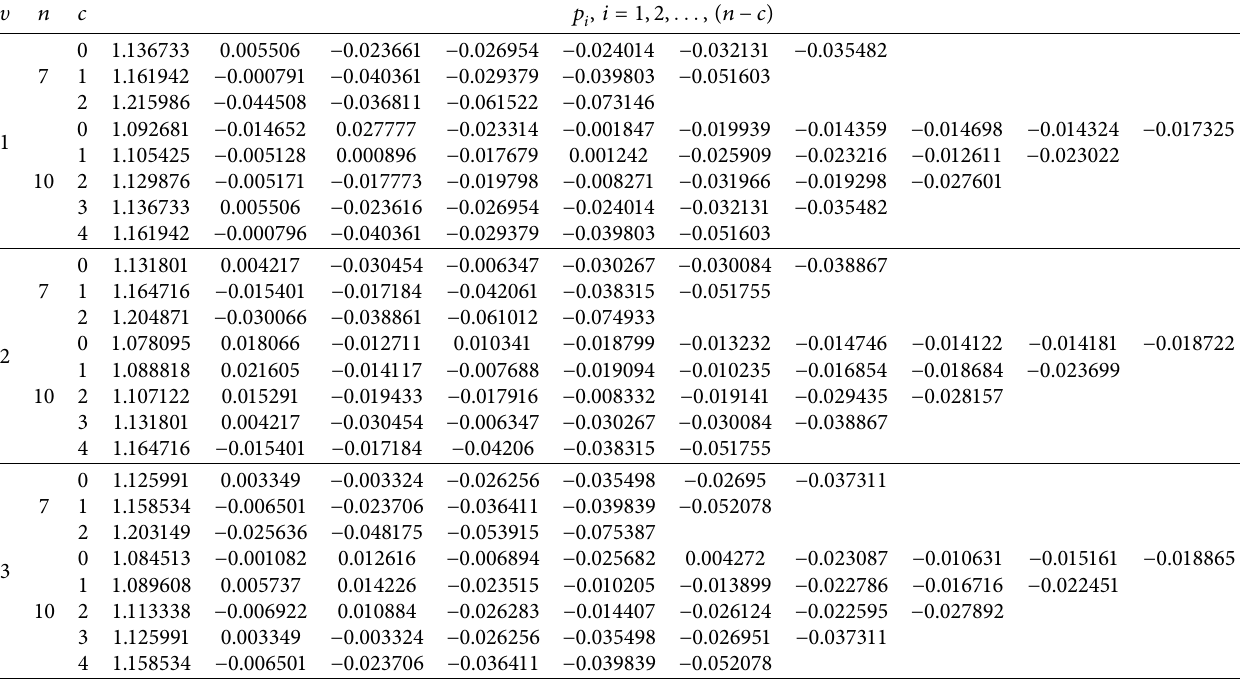
Table 1: Coefficients of the BLUEs of the location parameter.